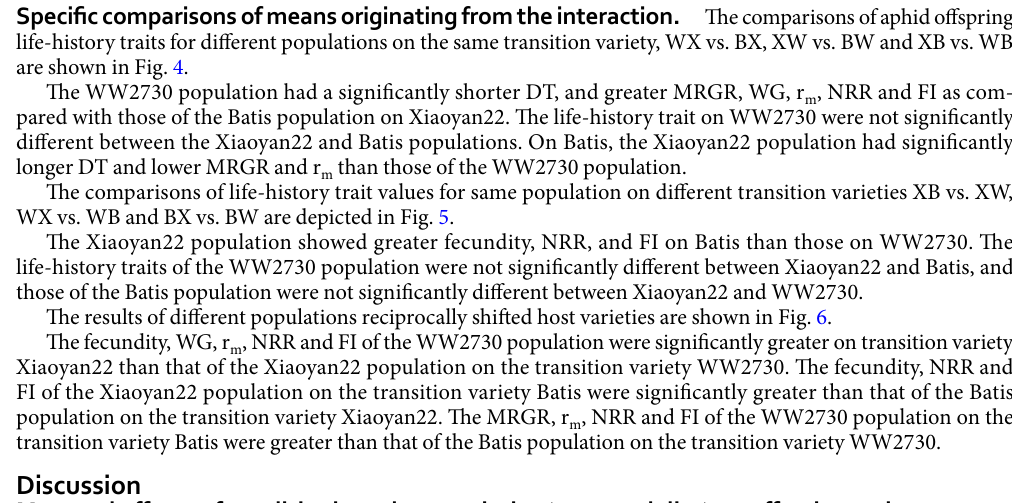
Figure 3. The population-level hierarchical traits, mean relative growth rates(MRGR), the intrinsic rate of natural increase (r m ), net reproduction rate (NRR), and fitness index (FI) change of Sitobion avenae with host